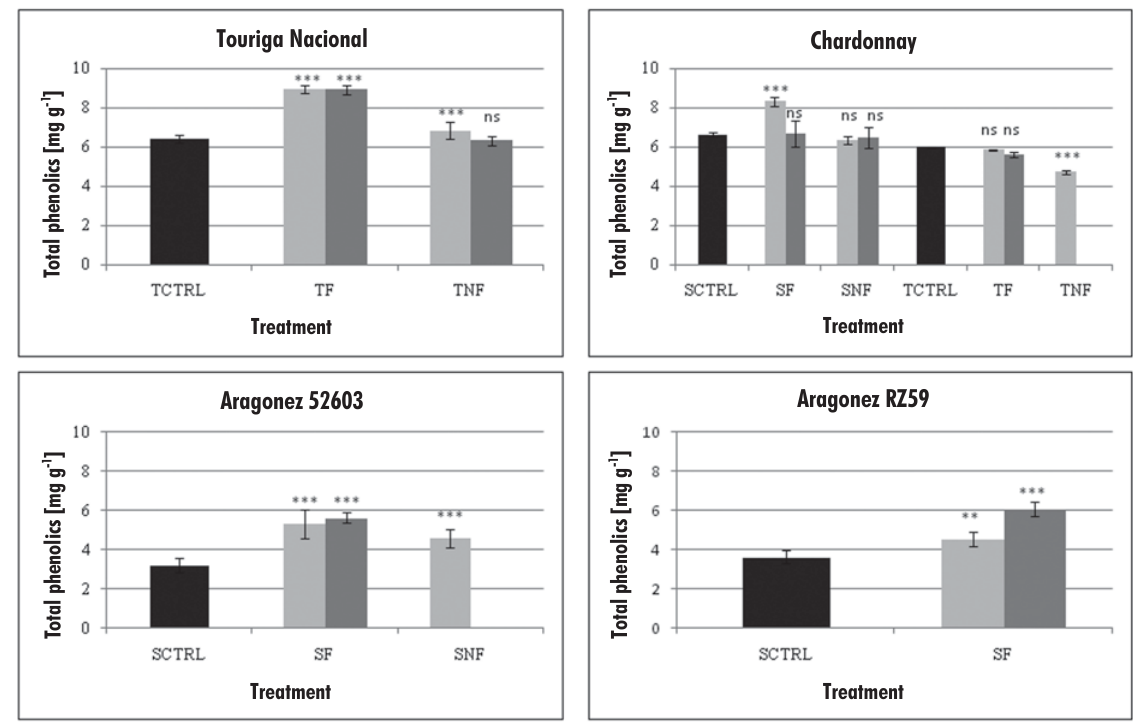
Fig. 1. Total phenolic compounds content within the methanolic extract from grapevine wood tissue from healthy and infected plants (cv. Touriga Nacional, cv. Chardonnay, cv. Aragonez [52603] and cv. Aragonez [RZ59]). Different tissue types are represented with infected plants: colonised trunk tissue (TF), uncolonised trunk tissue (TNF), colonised shoot tissue (SF) and uncolonised shoot tissue (SNF). Error bars represent standard deviation (n=6). Level of statistical signi fi cance is also indicated as *, P <0.05); **, P <0.01; ***, P <0.001; ns, non-signi fi cant. Control ( ¢ ), PH9 ( ¢ ), PH13 ( ¢ ). For control treatments, TCTRL refers to trunk control and SCTRL refers to shoot